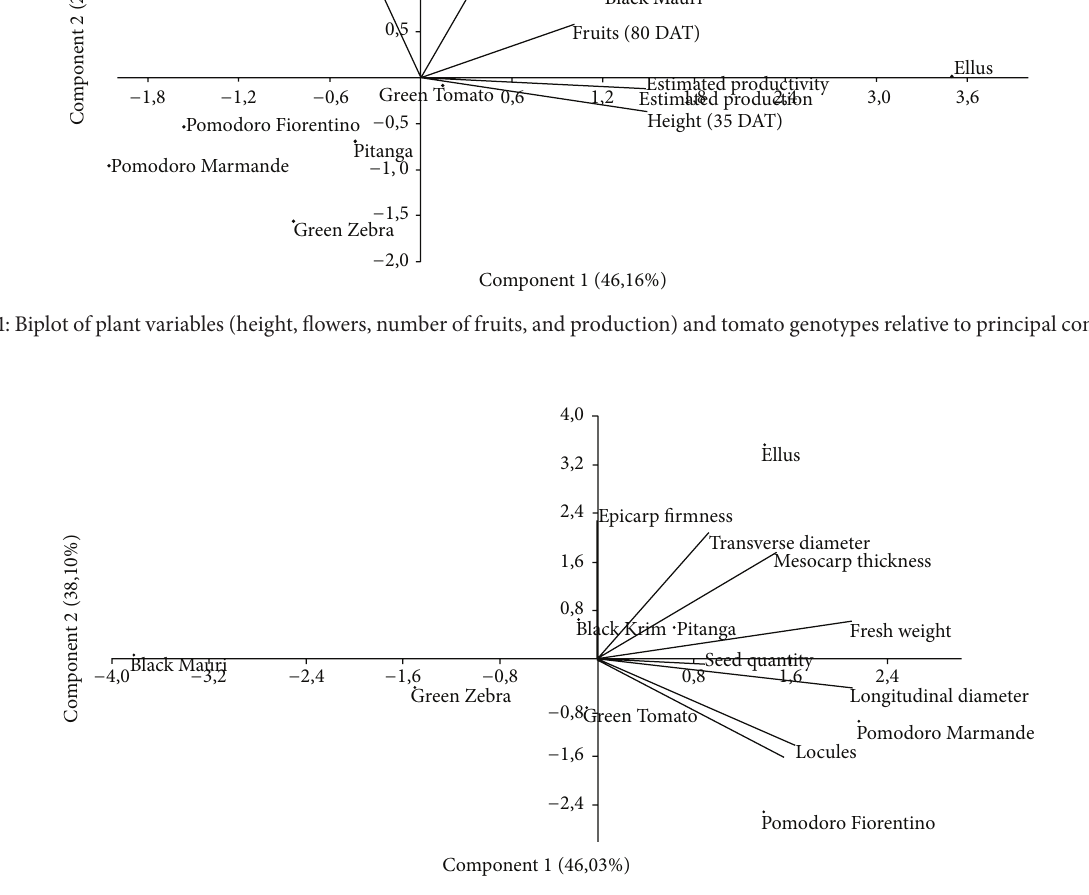
Figure 2: Biplot of fruit variables (fresh weight, longitudinal and transverse diameter, longitudinal and transverse diameter ratio, epicarp firmness, mesocarp thickness, locules, and number seeds) and tomato genotypes relative to principal components 1 and 2.